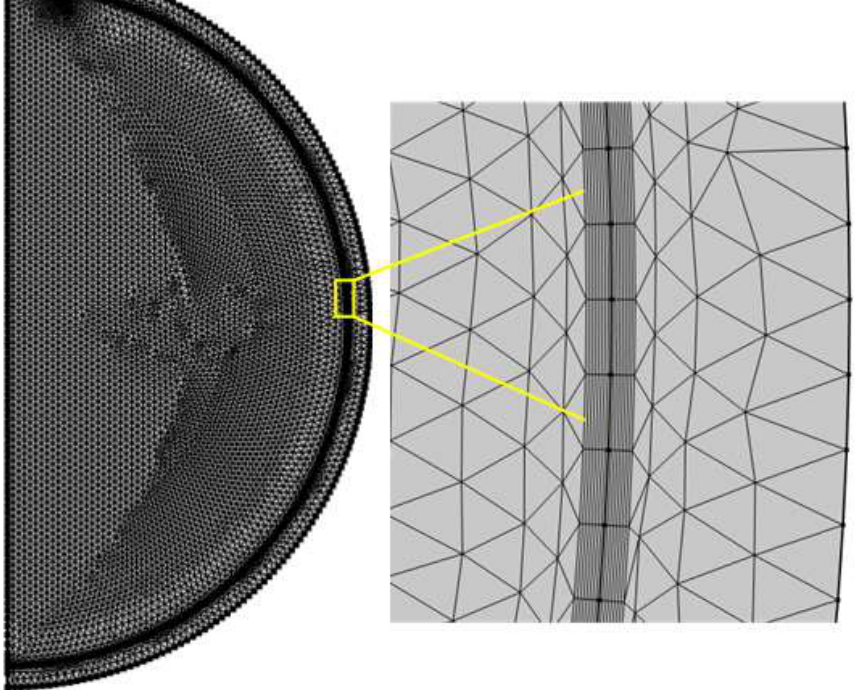
Figure 4. The mesh grid used in the two-dimensional axisymmetric finite element model.